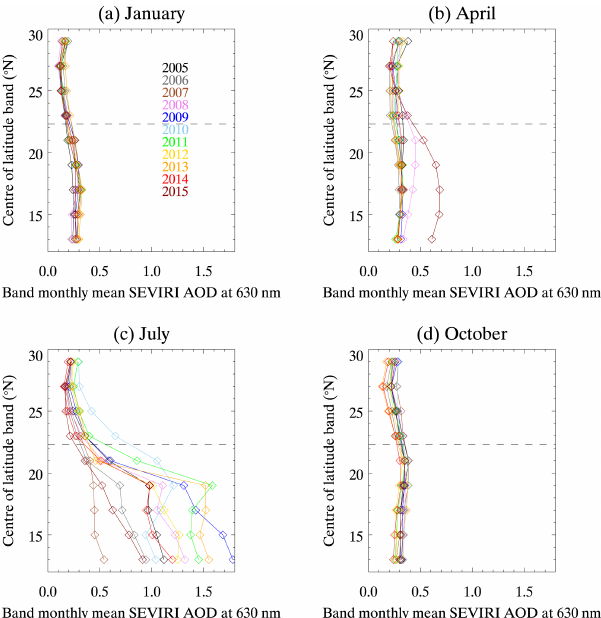
Figure 4. Monthly average AOD from SEVIRI by latitude band in the Red Sea. Colours represent individual years, and the dashed line at 22.3 ◦ N is the latitude of